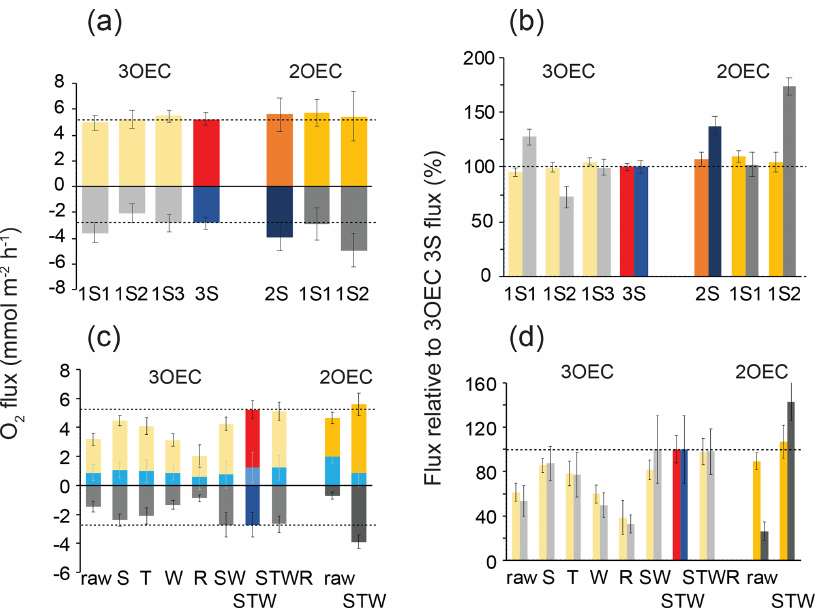
Figure 4. Comparison of fluxes based on single sensor signals and average signals, as well as the effects of flux corrections. Error bars represent standard error. (a) Comparison of the daytime (yellow/orange) and nighttime (grey/dark grey) fluxes averaged over all days based on individual sensors and sensor averages (day: red/brown, night: blue/dark blue). (b) Normalised 1S-, 2S-, and 3S-fluxes, colour code as in (a) . The 3S-flux (red/blue) was set to 100% (all data in (a) and (b) are STW-corrected). (c) Effect of corrections on 3S and 2S daytime, nighttime, and 24h fluxes (light blue) averaged over all days (error bars SE). Raw: not corrected; S : storage-corrected; T : time-shift-corrected; W : wave rotation-corrected; R : rotation-corrected. SW, STW, and STWR are combinations of the above corrections. (d) Normalised differences between the 3OEC STW-corrected average fluxes (set to 100%) and fluxes with no correction or different corrections recorded with the 3OEC and the 2OEC. Column colour coding in (c) and (d) as listed for (a) . Dotted lines allow for the comparison of the fluxes with the 3S-fluxes. Corresponding graphs based on the individual sensor readings are included in the